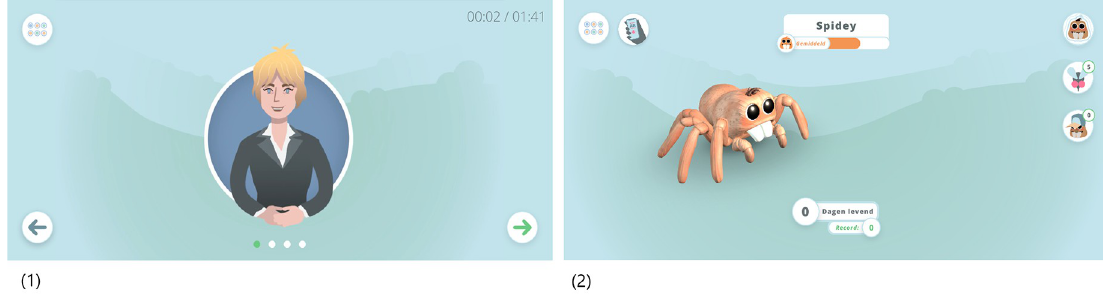
Fig 4. Screenshots of (1) animated therapist and (2) pet